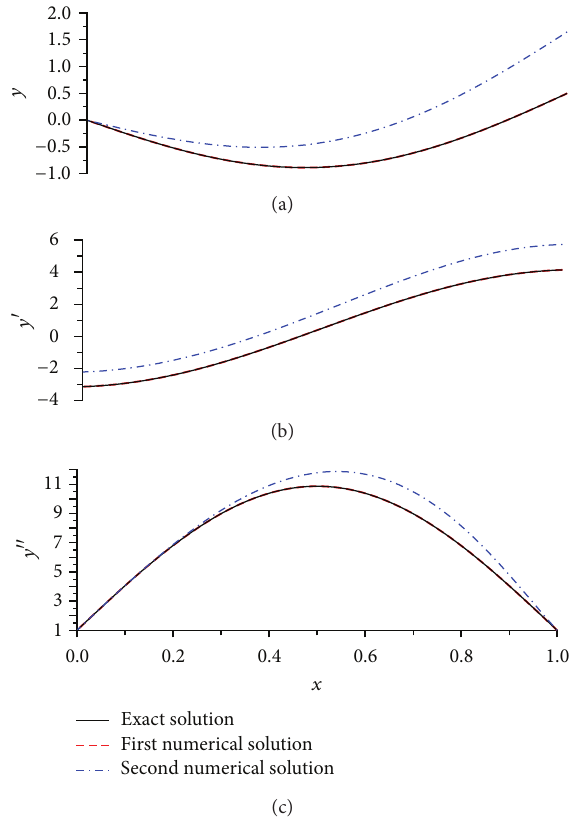
Figure 7: Example 4 solved by the SL (3, R ) method, (a) showing the error of mismatching and iterations number, (b) comparing the numerical and exact solutions, and (c) showing the numerical error of 𝑦